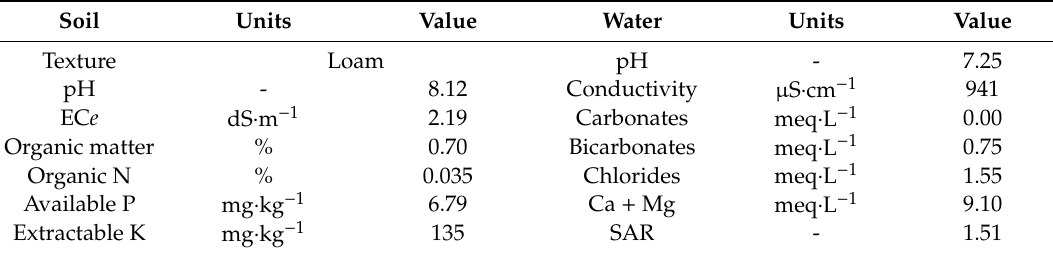
Table 1. Pre-experiment soil and water